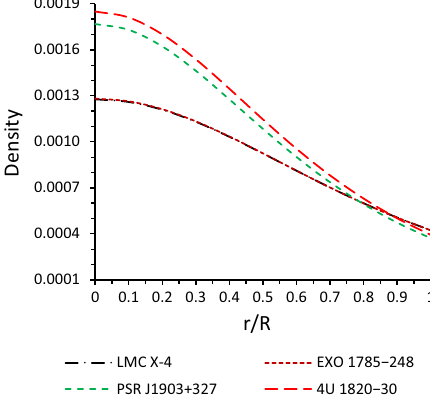
4U 1820-30. For plotting this figure we have employed data set values of physical parameters and constants as used in Fig. 1